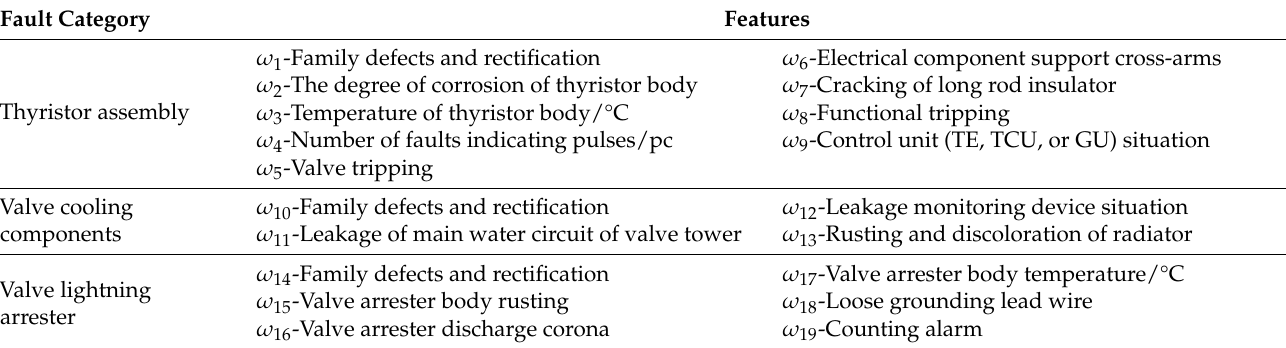
Table 3. Data Optimum